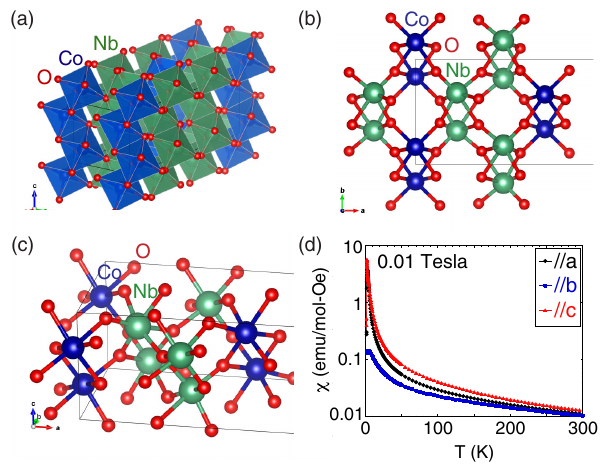
FIG. 2. (a) The crystal structure of CoNb 2 O 6 . (b) Both mag- netic CoO 6 and nonmagnetic NbO 6 octahedra form a chain along the c axis, as seen from the c-axis direction. The Nb-O-Nb chain is inside an isosceles triangle formed by three Co-O-Co chains. The transverse field h ⊥ is applied along the b axis. (c) Each Nb site is bonded with two Co-O-Co chains across O sites. (d) Bulk magnetic susceptibility χ data measured with SQUID in an external magnetic field of 0.01